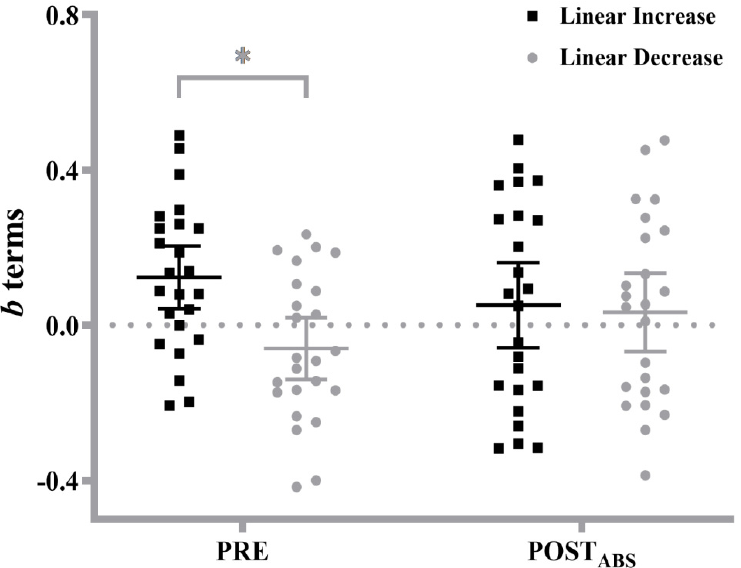
Figure 2. Individual values, means (horizontal bars), ± the 95% confidence intervals for the b terms from the mechanomyographic median power frequency vs. torque relationships at the pre-training (PRE) and post-training absolute (POST ABS ) torque levels for males and females. * indicates b terms were greater for females compared to males at POST ABS ( p = 0.013). # indicates b terms for females were greater at POST ABS than PRE ( p = 0.036).